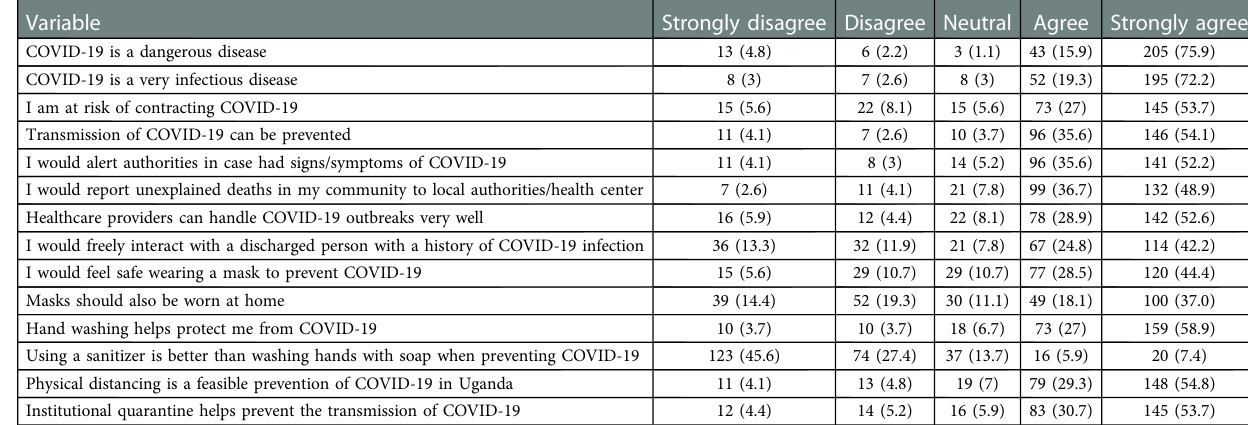
TABLE 3 Attitudes of respondents toward COVID-19 prevention and control measures.